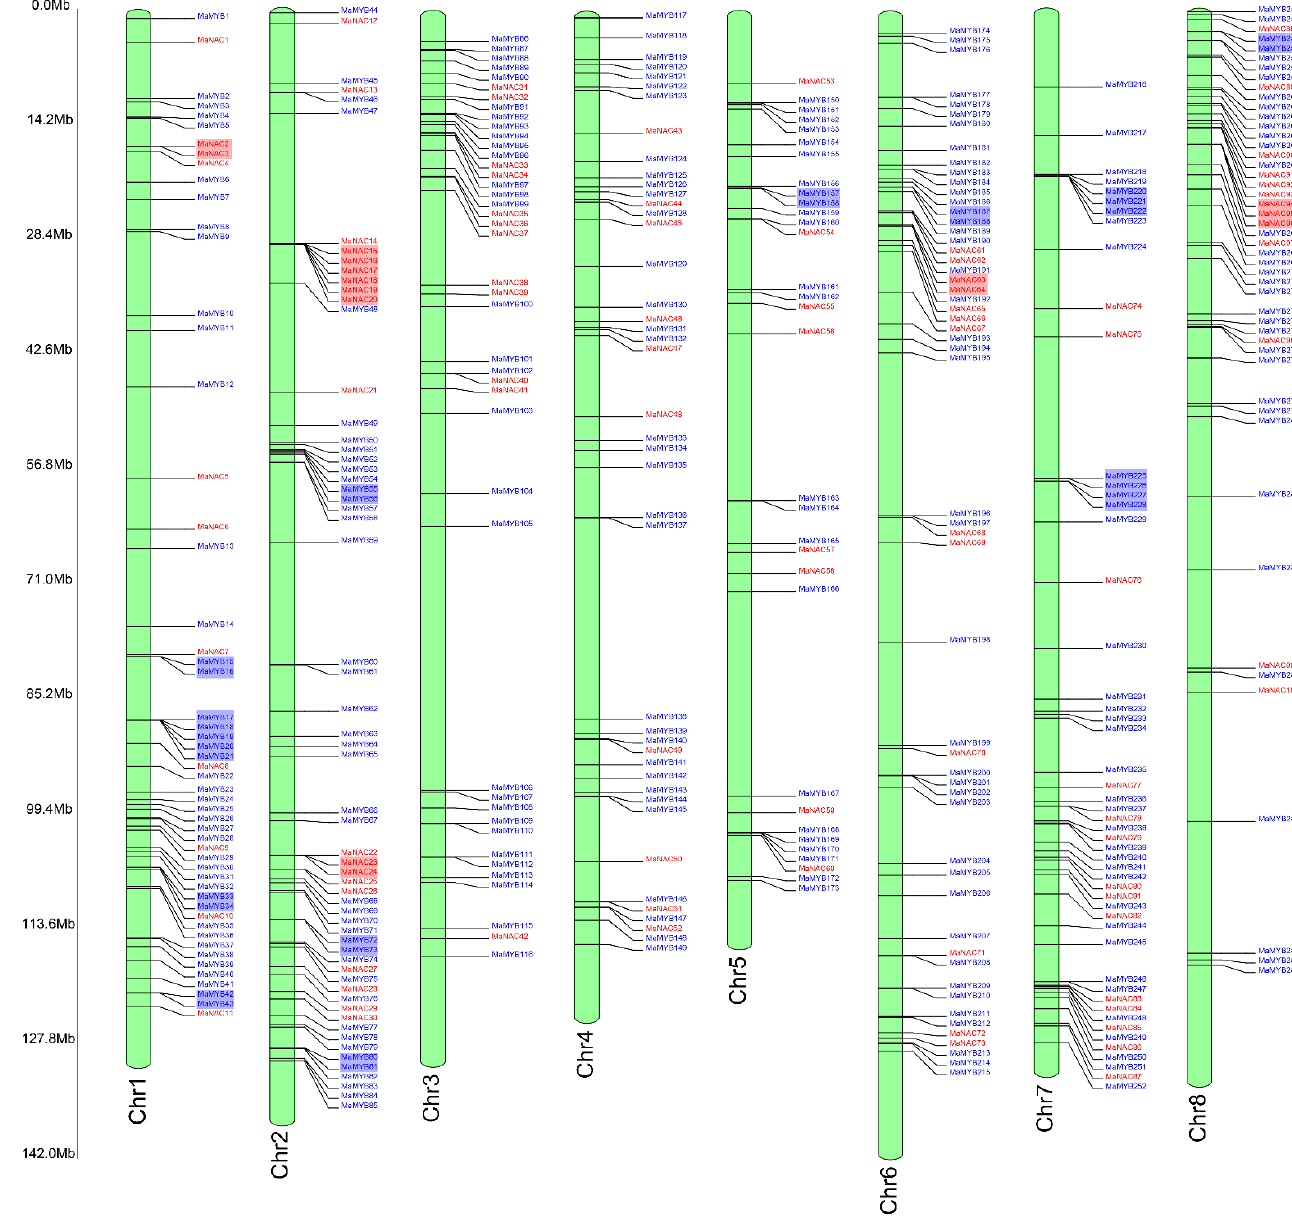
Figure 1. Chromosomal distribution of MaNAC s and MaMYB s. The red letters represent NAC transcription factors (TFs), and the blue letters represent MYB TFs. The red background represents tandem duplication genes of the NAC family. The blue background represents tandem duplication genes of the MYB family.